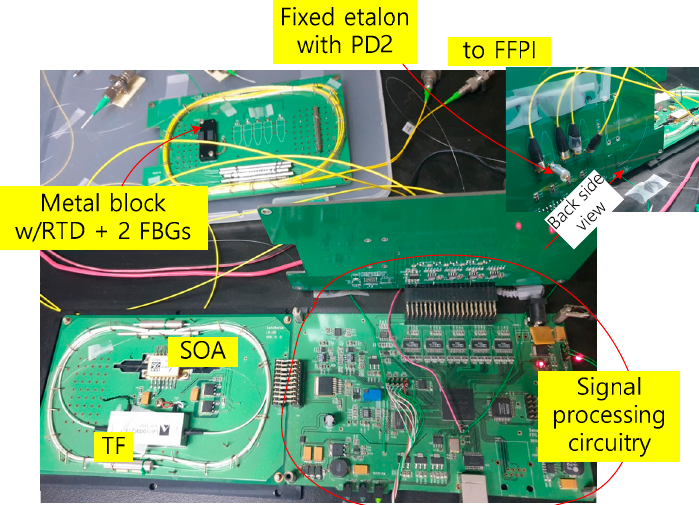
Figure 3. Photographic image of the experimental setup. The PD board (top right) is a picture of the backside of the PCB standing in the center.